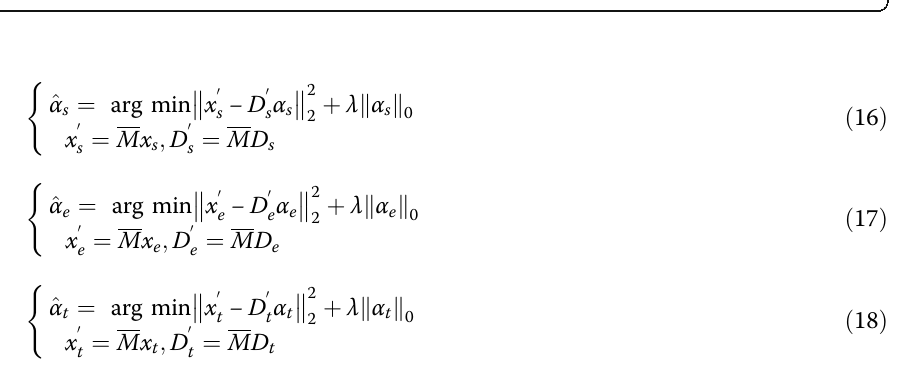
Fig. 3 Three dictionaries learned from image